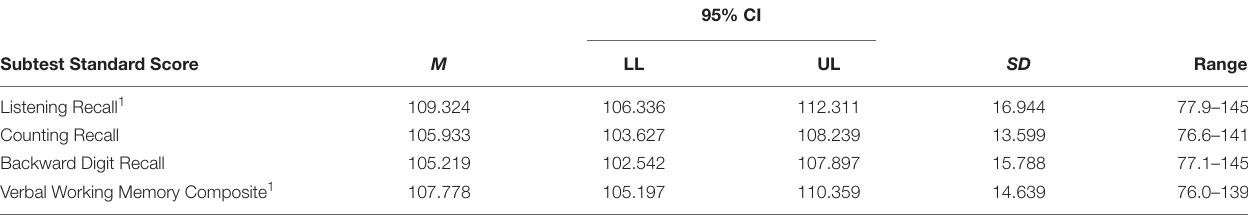
TABLE 2 | Descriptive statistics for standard scores from the automated working memory assessment.